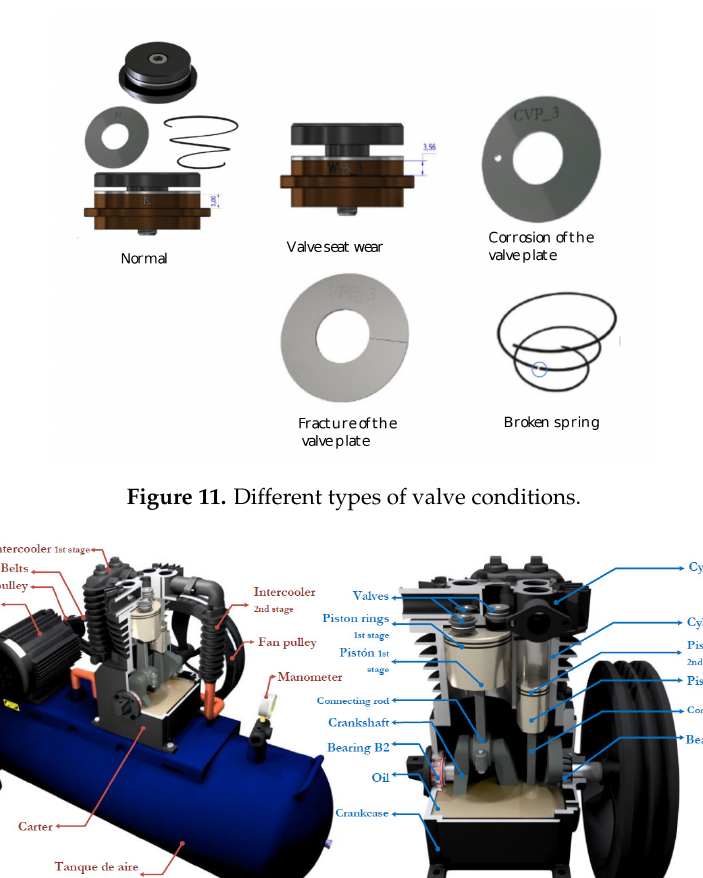
Figure 10. ( a ) Parts of the valve; ( b ) scheme of the assembly form.